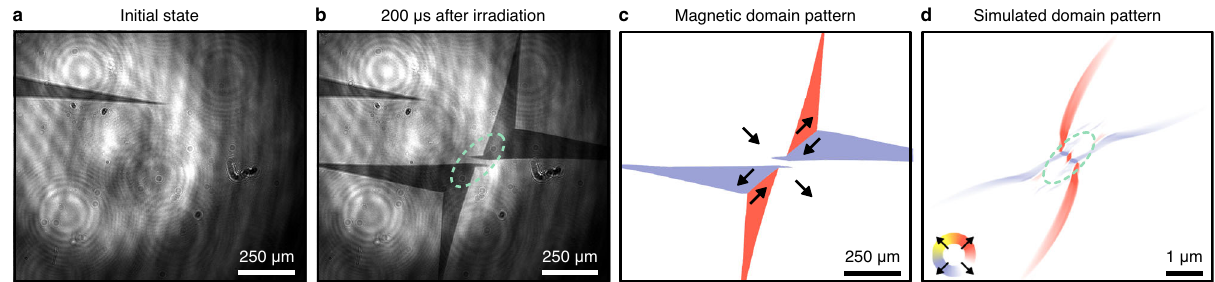
Fig.1|Phononicswitchingofin-planemagnetisationinLu:YIG. Magneto-optical images of the magnetisation distribution taken a before and b 200 μ s after irra- diation by a single pump pulse of wavelength 13 μ m and duration ≈ 2 ps. c The switchedmagneticdomainsisolatedbysubtractingthenon-magneticbackground.